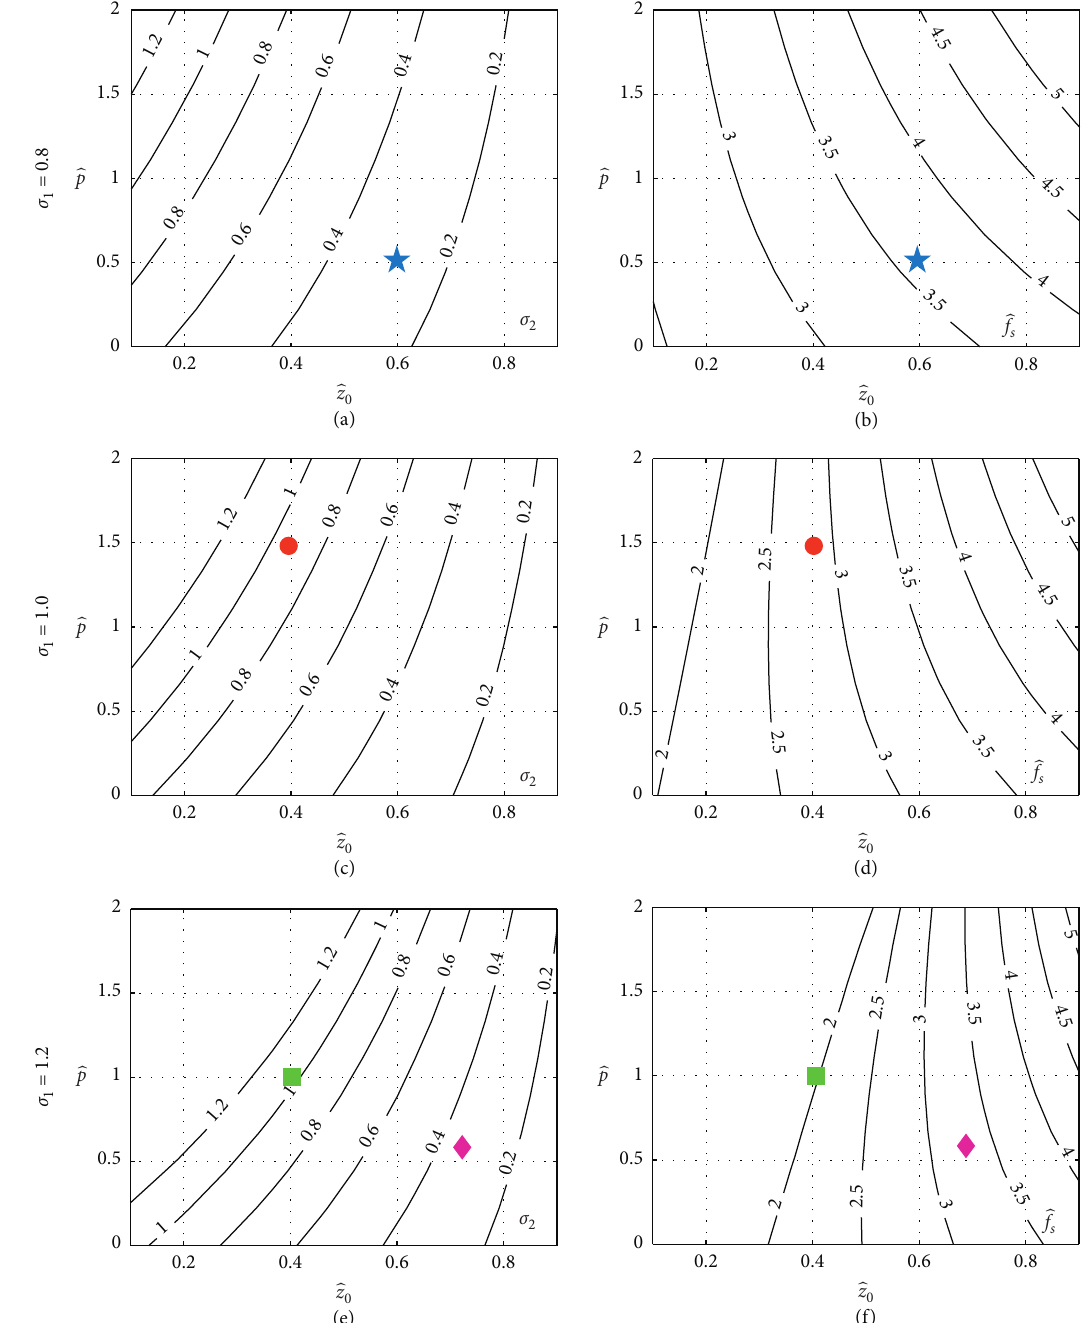
Figure 6: Contour plots for the design of an X -shaped suspension with QZS behaviour at large deflections: values of σ combinations of σ , 􏽢 z , and 􏽢 p . (markers will be described 1 0